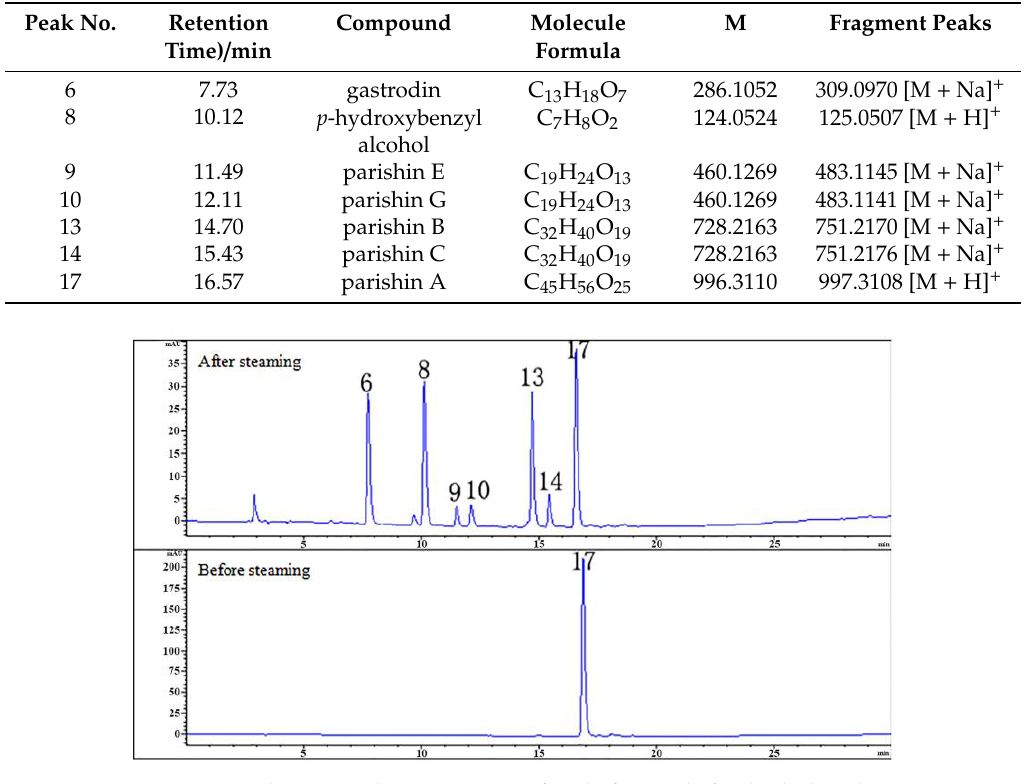
Figure 4. The HPLC chromatograms of PA before and after hydrolyzed. Table 3. ESI-TOF/MS accurate mass measurements of seven compounds in samples.